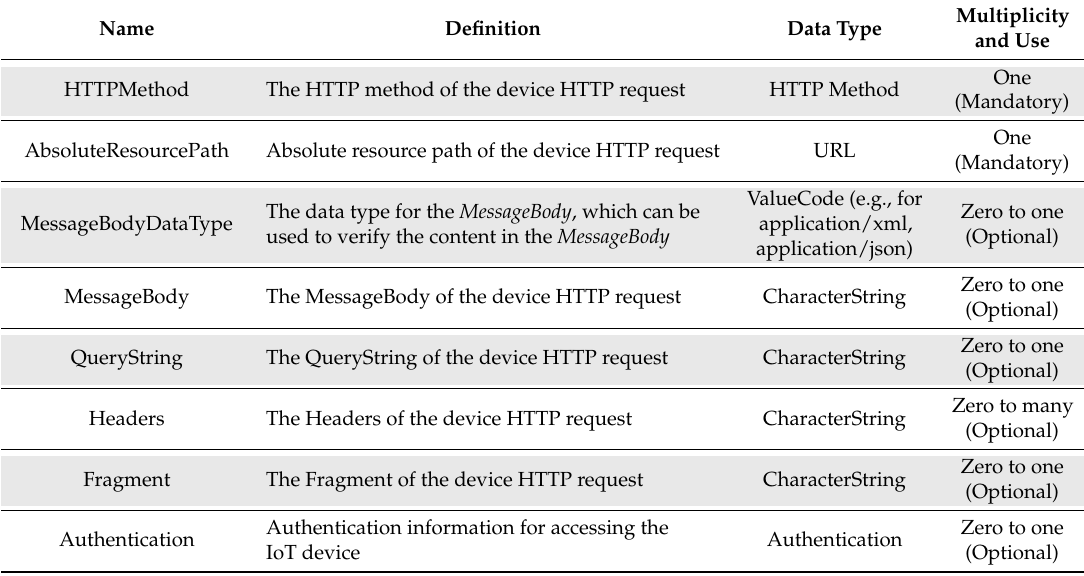
Table 8. Properties of the HTTPProtocol .